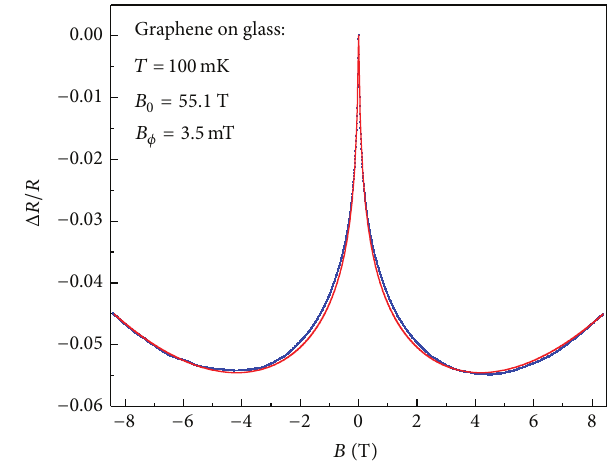
Figure 4: The measured magnetoresistance of a low mobility ( 𝜇 < 100 cm 2 /Vs) graphene Hall bar device at 100mK. The relative resistance (blues dots) and the fit using (19) with fitting parameters = 80 mT, 𝐵 = 10 T, and 𝐿 /𝐿 = 0.4 (red line) are shown. 𝐵 𝐵 𝑐𝜙 𝑒 𝜙 𝑐 and 𝐵 1 are larger than 100T and do not affect the fit.